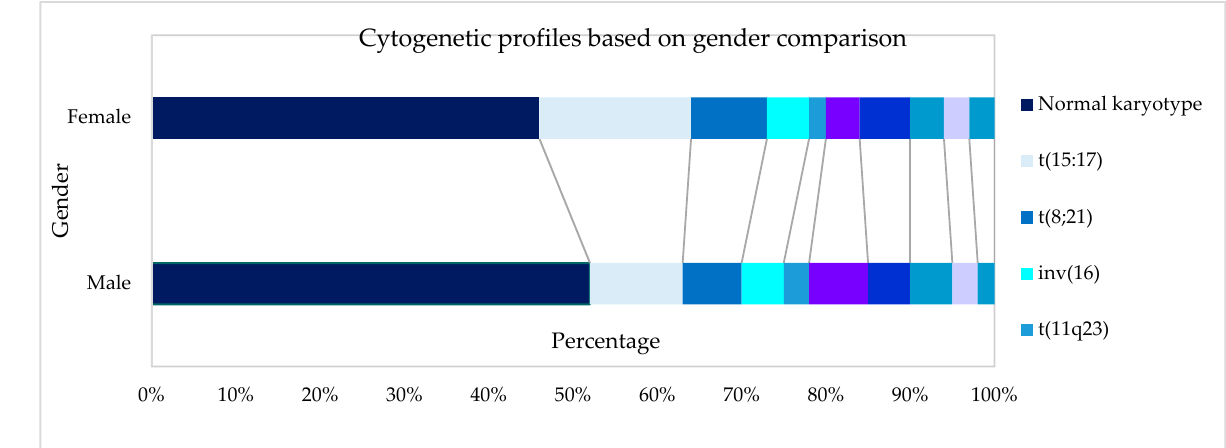
Figure 1. Cytogenetic profiles based on gender.